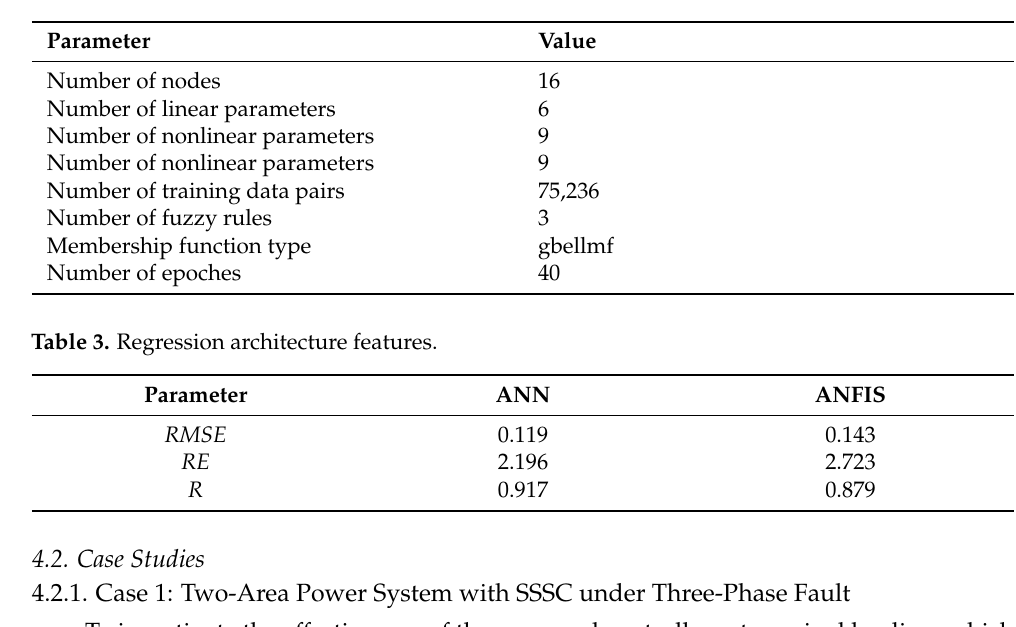
Table 2. ANFIS architecture features.